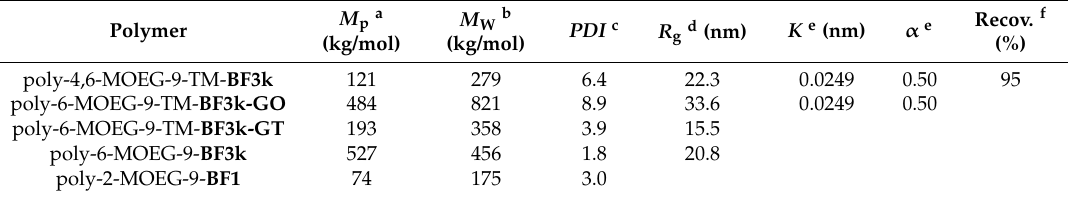
Figure 16. MALDI-TOF mass spectrum of poly-4’,6-MOEG-9-TM- BF3k . Table 2. Macromolecular features of the newly synthesized poly-4,6-MOEG-9-TM- BF3k compared with those shown by previously reported poly-6-MOEG-9-TM- BF3k , poly-6-MOEG-9- BF3k , and poly-2-MOEG-9- BF1 .